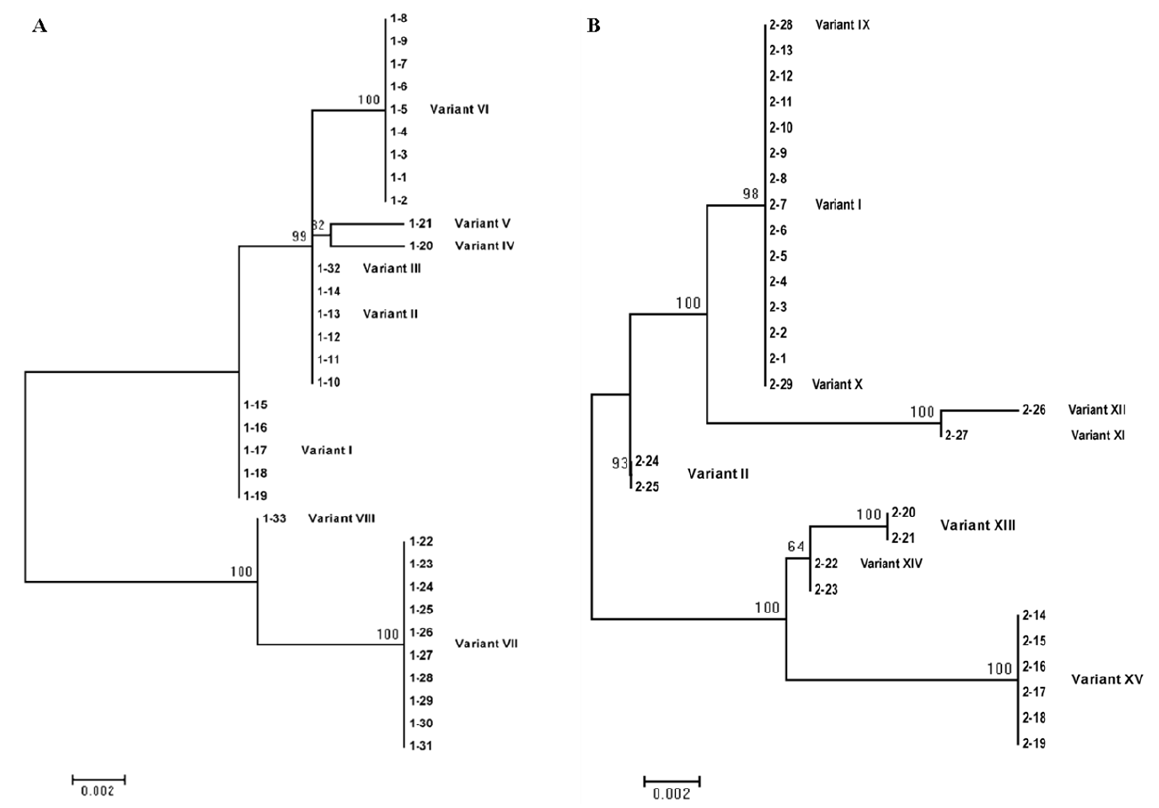
Figure 4. Phylogenetic analysis of Potato spindle tuber viroid (PSTVd) sequence variants. ( A ) Phylogenetic tree of PSTVd variants from plant one. ( B ) Phylogenetic tree of PSTVd variants from plant two. The analyses and tree constructions were conducted as described in Figure